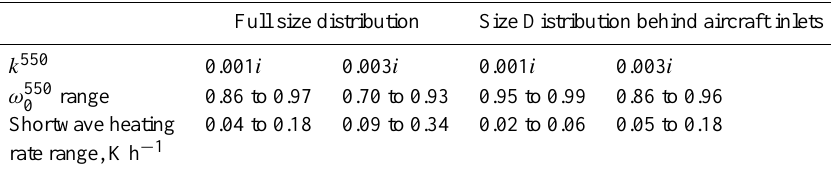
Table 5. Atmospheric dust instantaneous shortwave heating rates resulting from different SSA values and size distributions from radiative transfer calculations, using a broadband surface albedo of